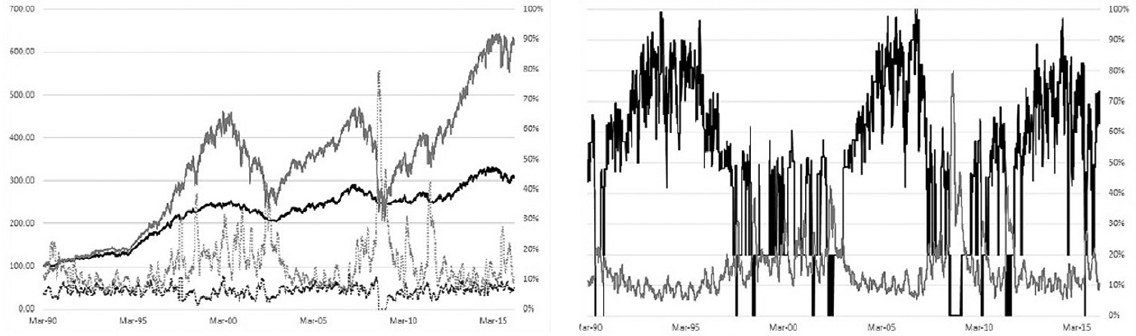
Figure 8. Comparative results for the DTVS VIX portfolio and the S&P 500 Note: The left side presents the path of DTVS VIX (solid black line) and of S&P 500 (solid gray line), and the DTVS VIX rolling standard deviation (dotted black line) and the S&P rolling standard deviation (dotted gray line). The right side presents how the equity exposure of the DTVS VIX (solid black line) changes with respect to the volatility of the S&P 500 (solid gray